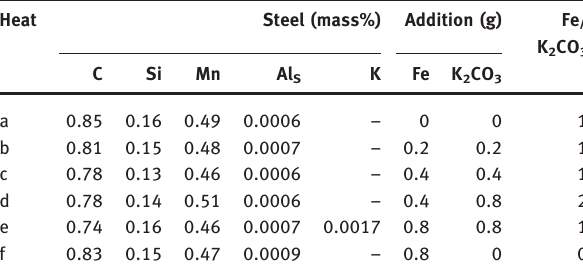
Table 4: Chemical compositions of steel after reaction.